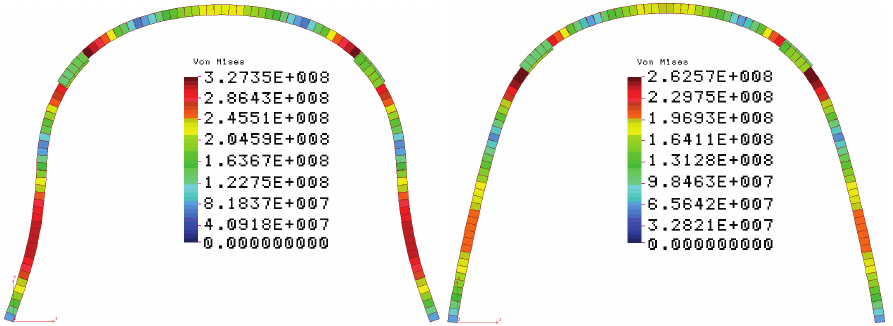
= 0.1 MN/m, stresses in Pa, s